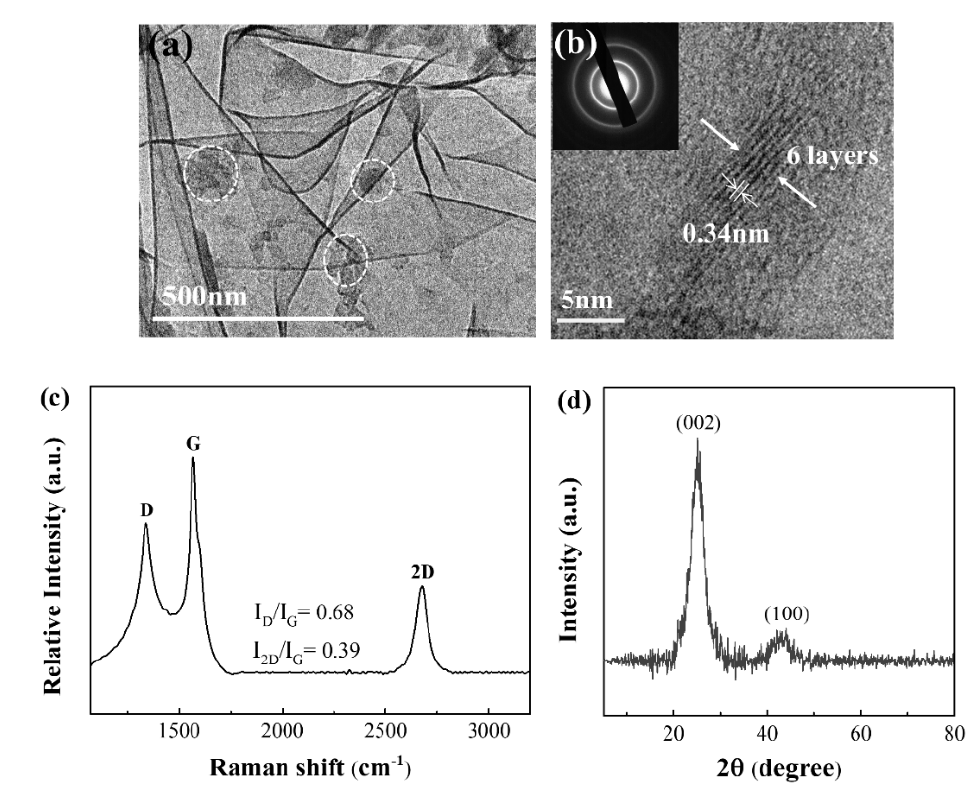
Figure 1. ( a ) Transmission electron microscopy (TEM ) image and ( b ) High resolution transmission electron microscope (HRTEM) image of as–prepared graphene by pyrolysis of Polypropylene (PP) with 20 wt.% Diatomite (DM–20/PP). The inset in ( b ) shows the Selected area electron diffraction (SAED) pattern of graphene layers. ( c ) Raman spectra and ( d ) X-ray diffraction (XRD) pattern of the as-prepared graphene by pyrolysis of DM–20/PP.